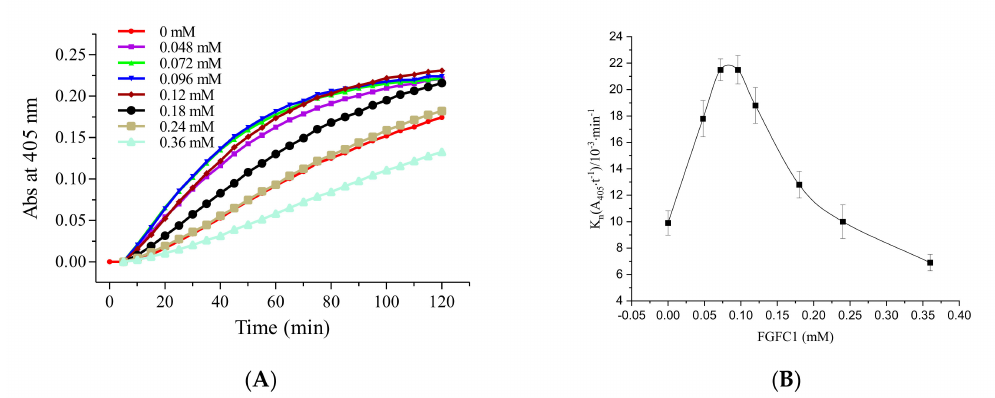
Figure 4. The fibrinolytic characterization of FGFC1 mediated by pro-uPA and Lys-plasminogen. Plot of A 405 versus time ( A ) and the values of Kn ( B ) at different FGFC1 concentrations (0–0.36 mM). The reaction was incubated at 37 ◦ C and measured every five minutes for 120 min. The results are expressed as the mean ± SD, performed in triplicate. The concentration of pro-uPA and Lys-plasminogen in the reaction system were 9 and 4 nM, respectively.